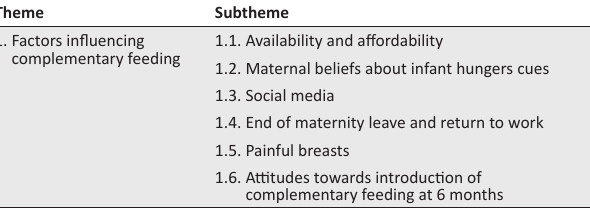
TABLE 4: Themes and sub-themes emerged from data